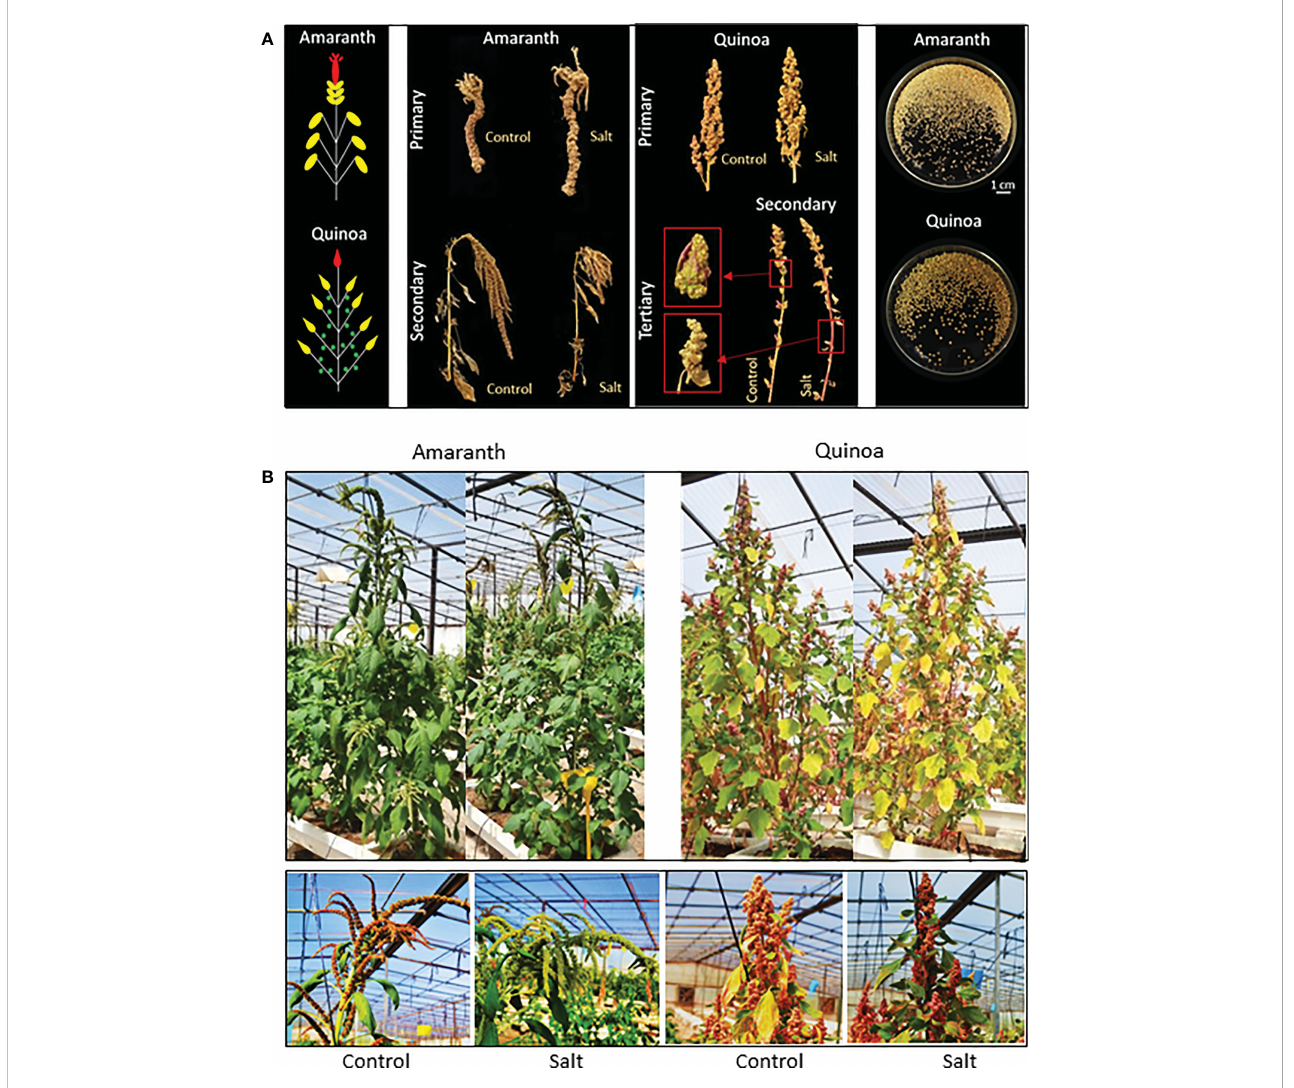
FIGURE 5 Seed yields are obtained from different panicle types of amaranth and quinoa. (A) Left, diagram showing the locations of the main or primary panicle ( fi rst panicle to emerge) colored in red, secondary panicles at the tip of each branch (second panicle, emerging after the main panicle) colored in yellow, and for quinoa also tertiary panicles from nodes within branches (third panicle, emerging after the second panicle) colored in green; in center and right, representative images of different panicles and seeds of amaranth and quinoa on the day of harvesting, from plants grown in control and salt stress (100 mM NaCl). (B) Phenotype of amaranth and quinoa plants in control condition and after 30 days of salt treatment, and images of main panicles. At this time, the physiological maturity of quinoa plants began to be observed, which does not occur in amaranth. Adapted from Figures 7, 8 of Estrada et al., 2021. Unraveling the strategies used by the underexploited amaranth species to confront salt stress: similarities and differences with quinoa species. Front. Plant Sci. 12:604481. doi: